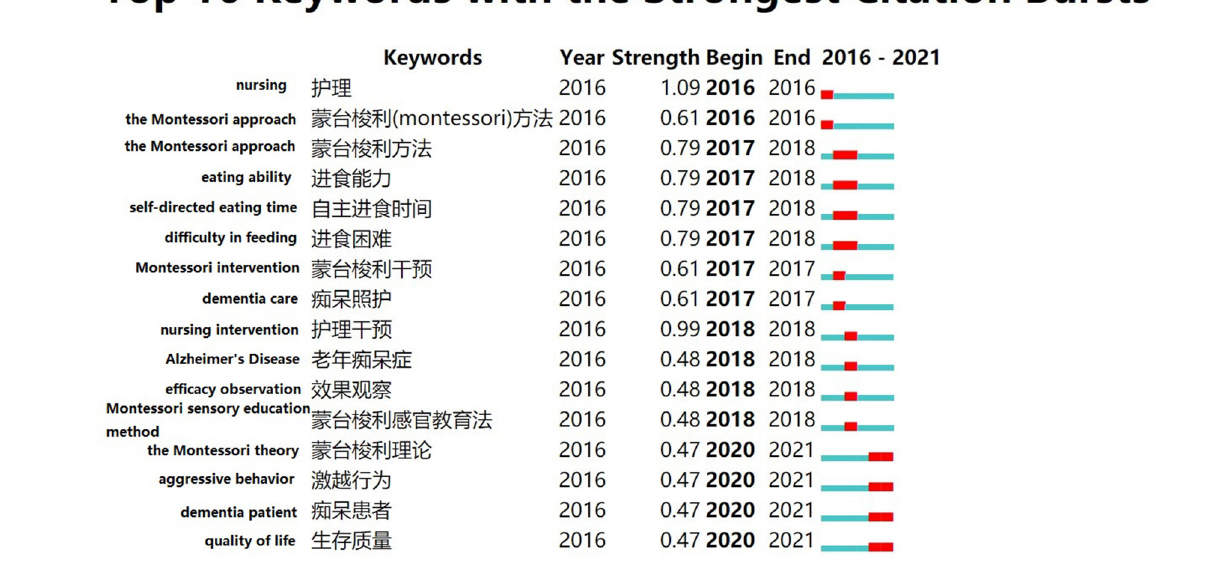
FIGURE 7 | Keyword burst graph of articles published in Chinese on Montessori approach to interventions for dementia patients from 2000 to 2021.